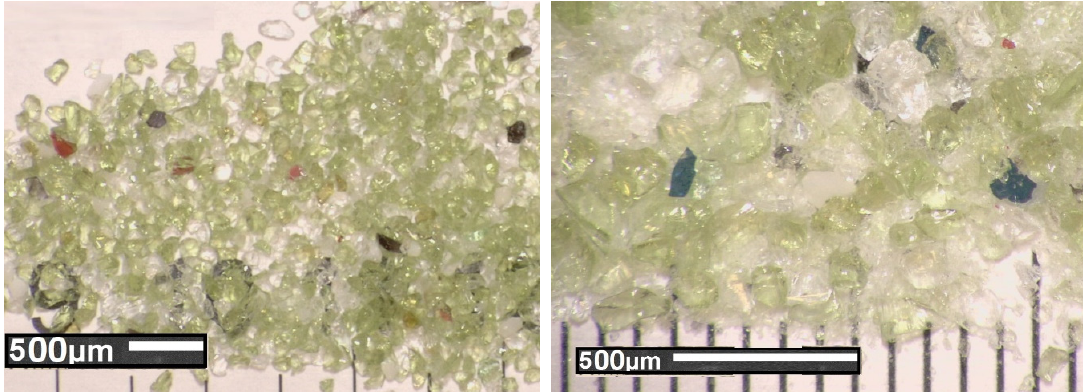
Figure 2. Light microscope (OPTA-TECH STX12, Opta-Tech, Warsaw, Poland) images of glass aggregate.